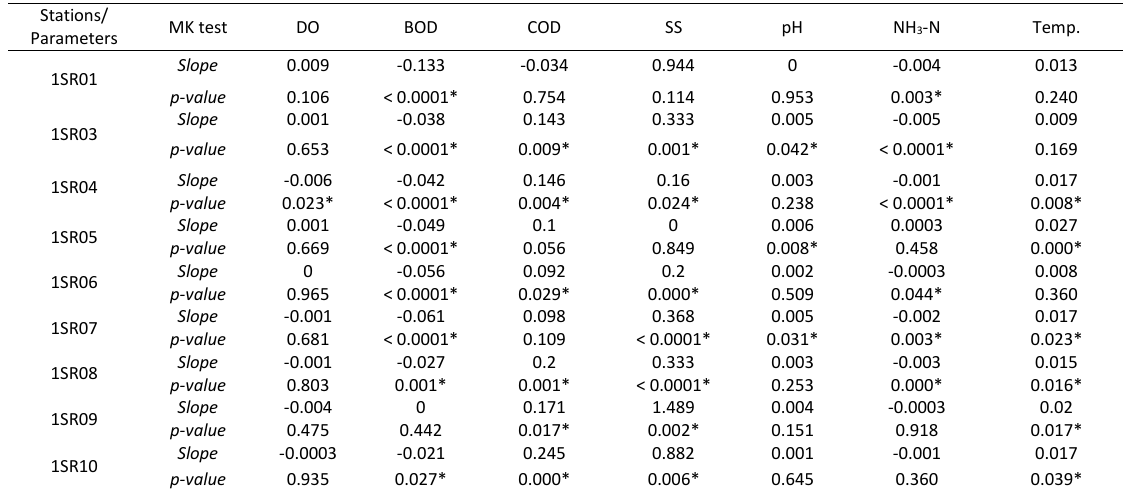
Table 4: R esults o f MK trend test of water quality parameters at the stations Stations/ Parameters